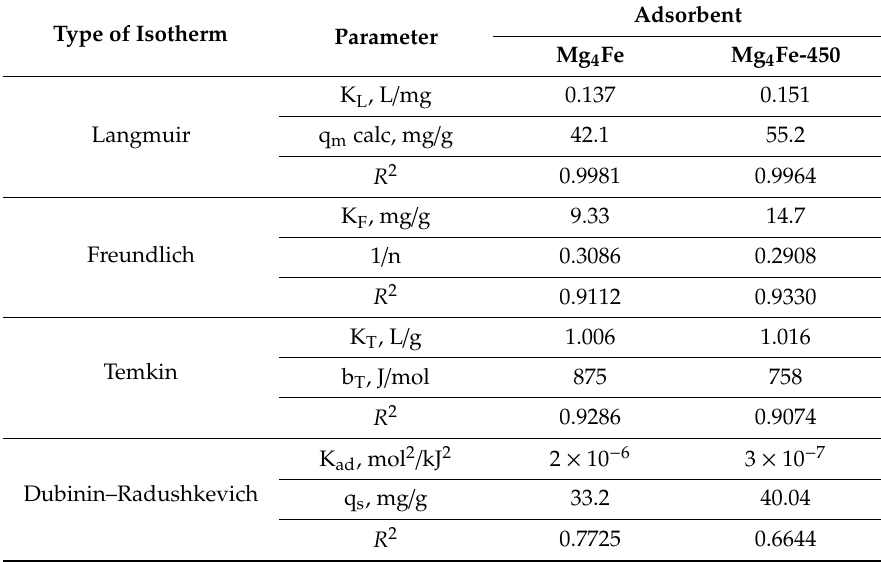
Table 3. Equilibrium sorption isotherm parameters for Mo(VI) adsorption onto Mg 4 Fe and Mg 4